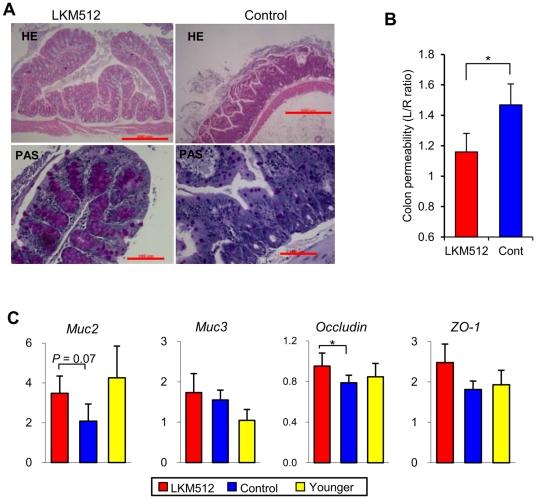
Influences of LKM512 administration on colonic barrier function.(A) Histology of proximal colon samples from mice treated with LKM512 (left) or PBS (control; right). The samples shown in the upper panels are stained with HE, while those in the bottom panels are stained with PAS. [Scale bars, 500 µm (HE), 100 µm (PAS).] (B) Colon permeability at week 25, as indicated by the urinary lactulose/rhamnose ratio. (C) Colonic gene expression of Muc2, Muc3, Occludin, and ZO-1 in all treatment groups and in younger mice. Data are represented as mean ± SEM. *P<0.05.